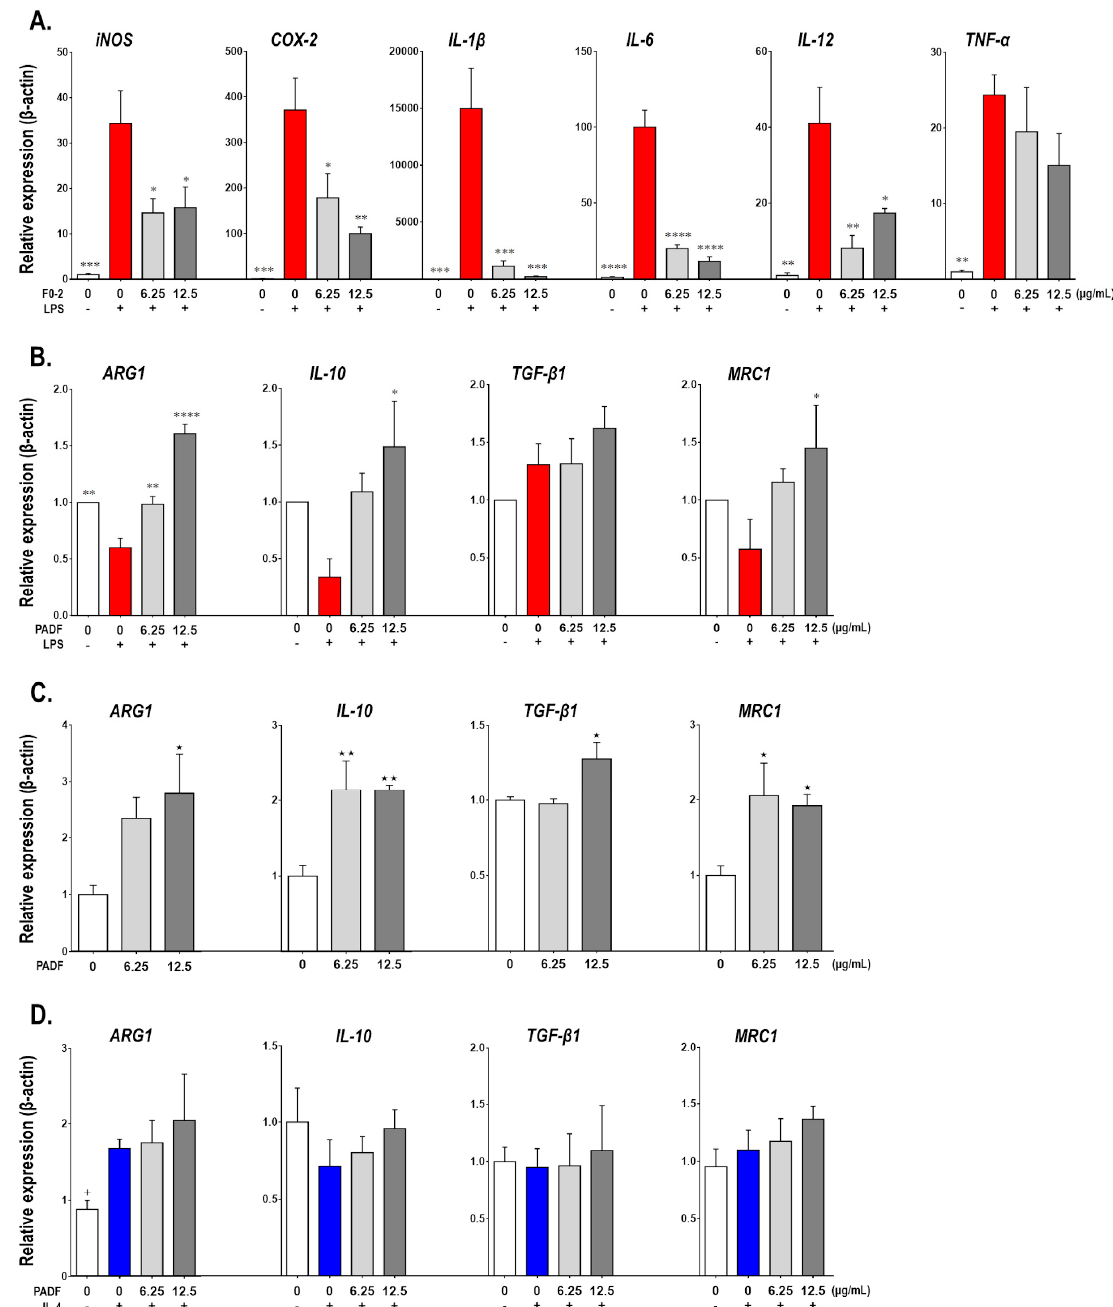
Figure 1. Physalis angulata fraction (PADF) polarizes macrophages towards an anti-inflammatory profile. Naïve RAW 264.7 macrophages were treated with PADF (6.25 and 12.50 μ g/mL) or vehicle (positive and negative controls) and then stimulated with LPS [M(LPS)] or IL-4 [M(IL4)]. The expression of pro-inflammatory gene markers was quantified for inflammatory M(LPS) macrophages ( A ); while the expression of anti-inflammatory markers was assessed for inflammatory M(LPS) ( B ), naïve ( C ), and alternatively M(IL-4) ( D ) macrophages. All graphs show the mean ± SEM of at least three independent experiments ( n = 4–9). * p < 0.05, ** p < 0.01, *** p < 0.001, **** p < 0.0001 significantly different from M(LPS) control; + p < 0.05 significantly different from M(IL-4) control; or * p < 0.05, ** p < 0.01 significantly different from naïve control (ANOVA, Dunnett’s multiple comparisons test).